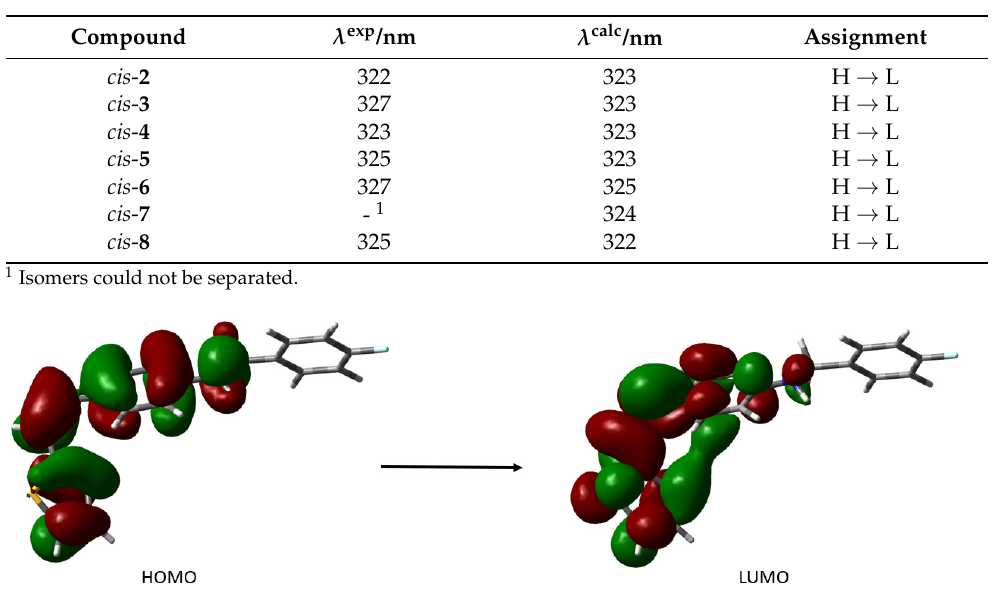
presented in Figure 8.